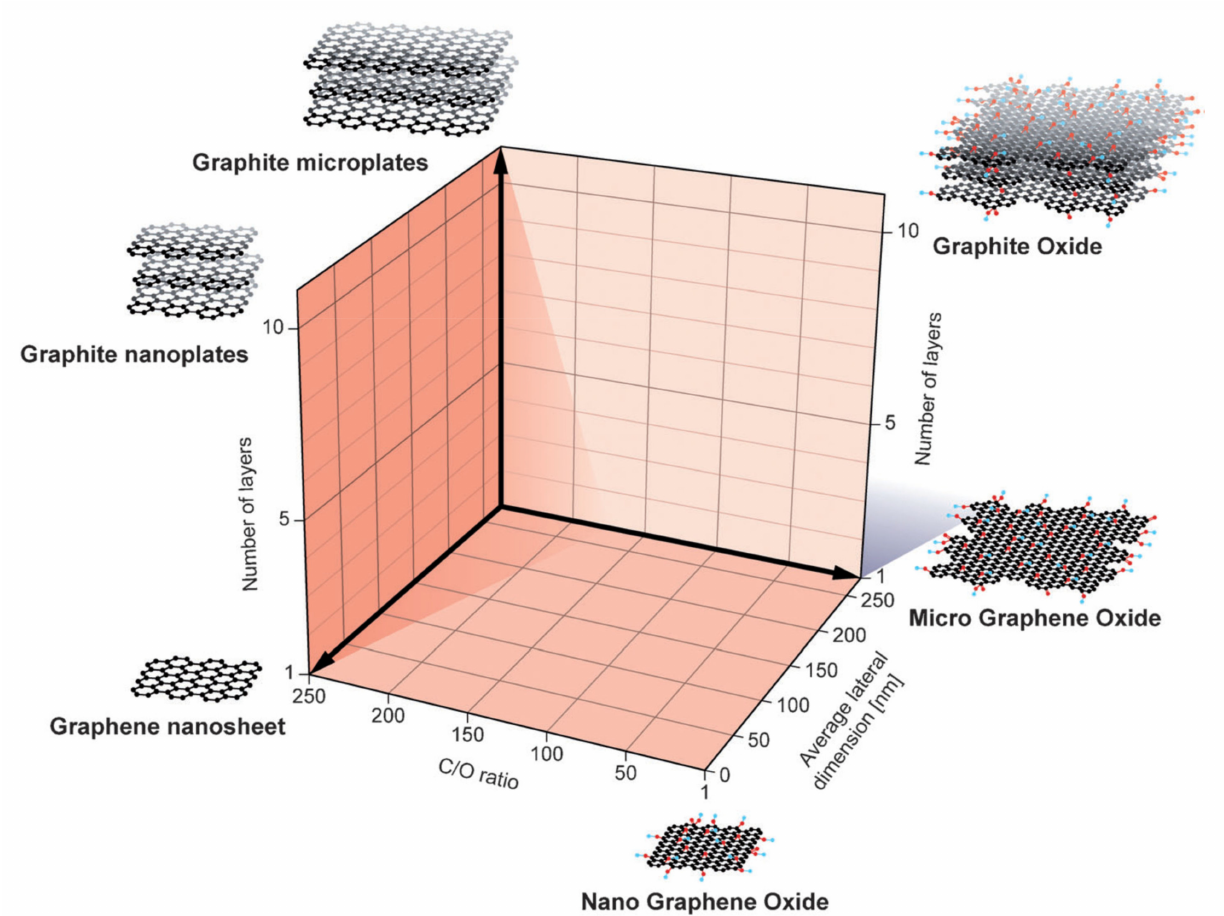
Figure 4. Classification of graphene-based materials. (Reproduced with permission from ref [34]). Later, in 2017, a detailed guideline for the nomenclature and standardization of graphene was proposed by the International Organization for Standardization (ISO)